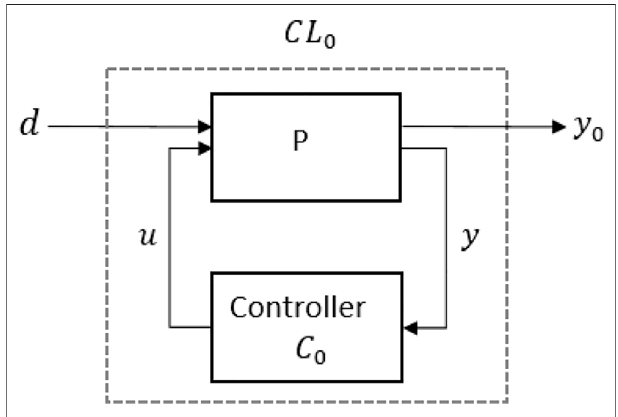
FIGURE 3 | Control scheme represented as LFT system.